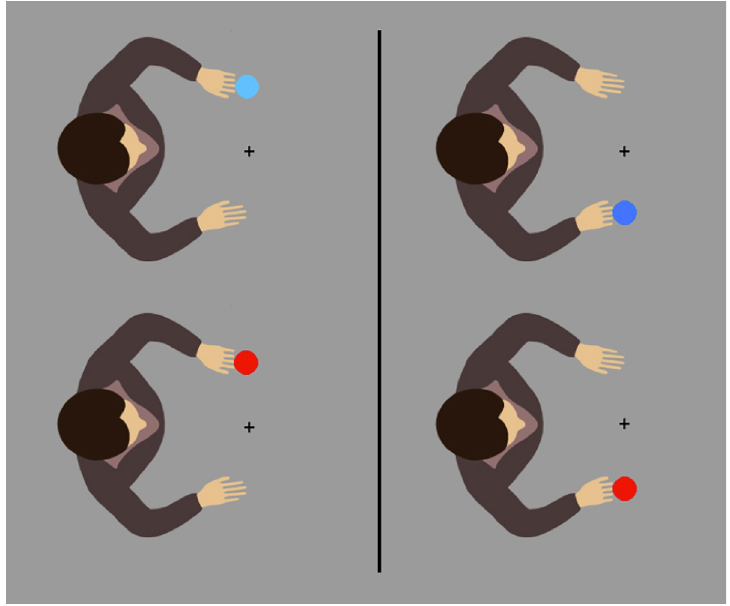
Fig 3. Avatars in Experiment 2. Avatars used in the second experiment with the avatar on the left side. The top row shows the initial setup before a response was given, the bottom row illustrates the two possible action effects.